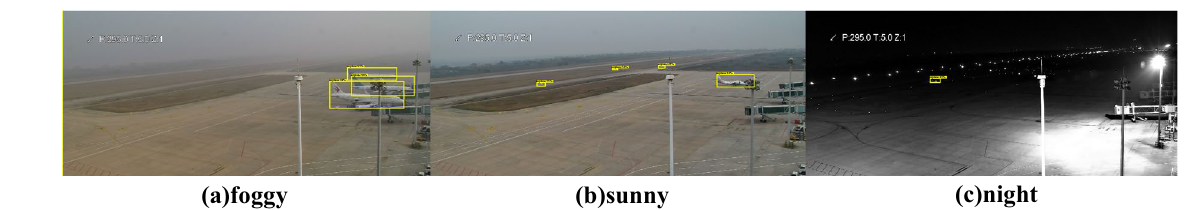
Figure 9. YOLOV3 detection renderings in different scenarios.